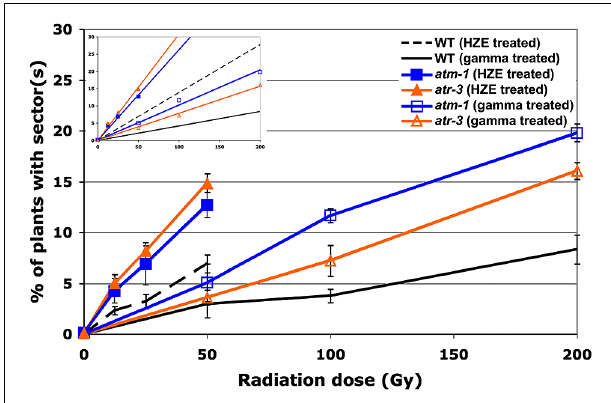
FIGURE 4 | Loss of heterozygosity in cell-cycle checkpoint-deficient plants in response to HZE and gamma radiation. Data points represent the mean of three biological replicates. Error bars depict standard deviation, calculated as before via Microsoft Excel. Inset: Linear regressions for each